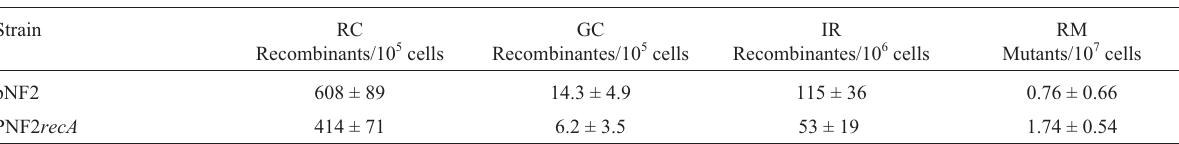
Table 1 - Spontaneous frequences of reciprocal recombination (RC), gene conversion (GC), intrachromosomal pop-out recombination (IR) and reverse mutation (RM) in yeast mitotic cells expressing (pNF2 recA ) or not (pNF2) the recA gene.